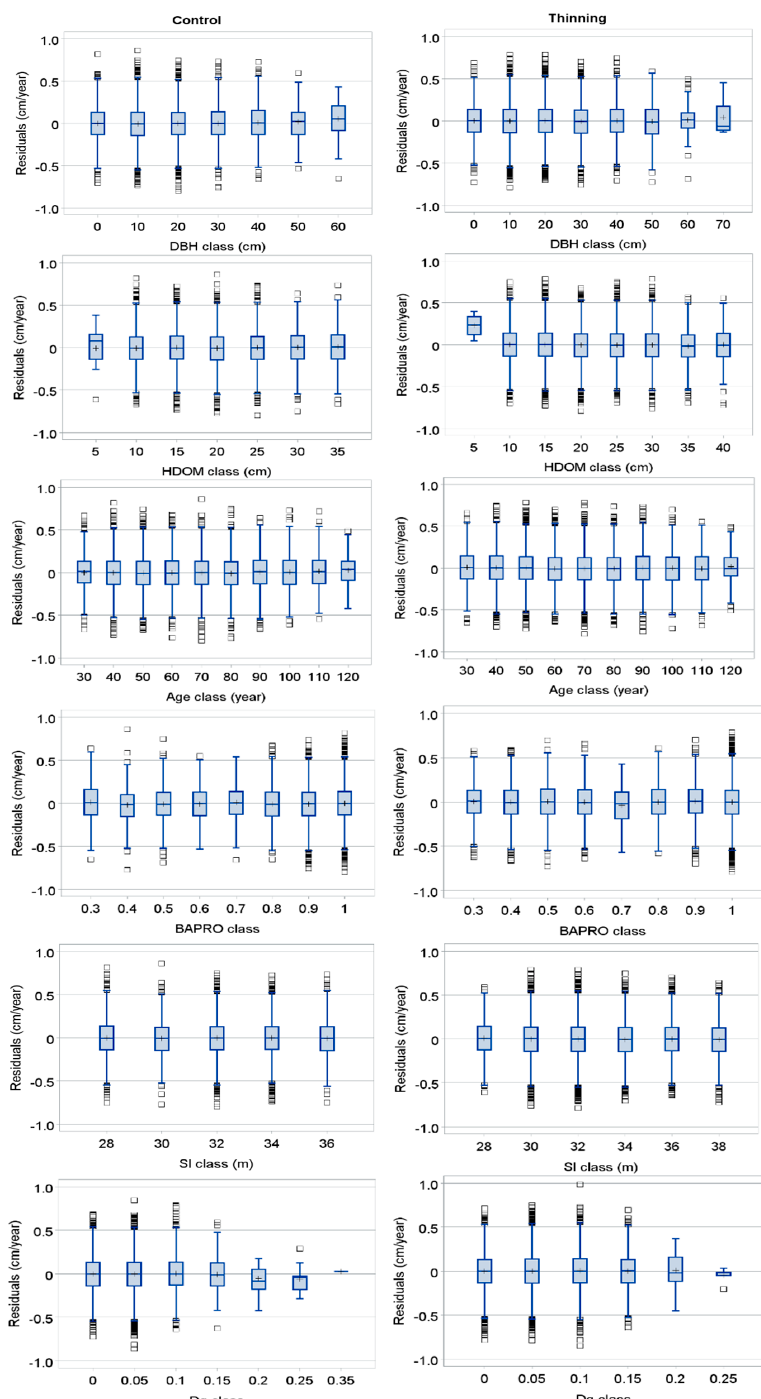
Figure 4. Box plots of the standardized residuals of the mixed-effects model. Length of larger box represents the interquartile range (IQR), length of whisker represents class minimum and maximum values in the IQR, and smaller boxes represent the observations 1.5 times beyond the IQR (outlier observations lying far away from the median) and horizontal lines and plus signs in a larger box represent class median and mean values, respectively. DBH: Diameter at breast height; HDOM: dominant height; BAPRO: Basal area proportion of a species of interest; SI: Site index; Dq: Ratio of DBH to quadratic diameter.